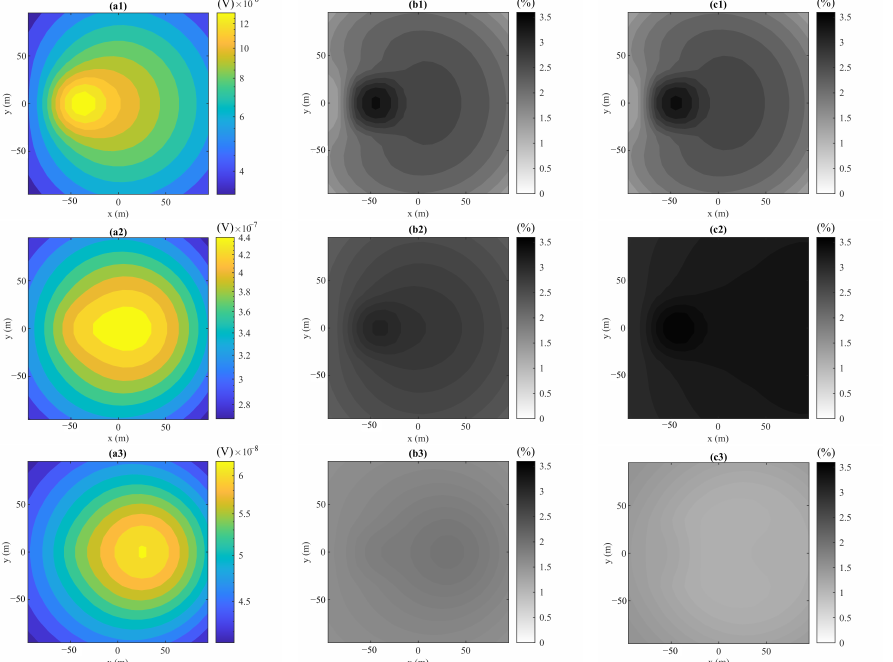
Figure 7. Example 2: ( a ) Forward modeling response ( − d b z /d t ) of MR grid approach. Relative differences of SG grid solution ( b ) and MR grid solution ( c ) against the SLDM solution. Rows 1–3 correspond to the time gates at 5.29 × 10 − 5 s, 2.55 × 10 − 4 s, and 7.27 × 10 − 4 s, respectively.